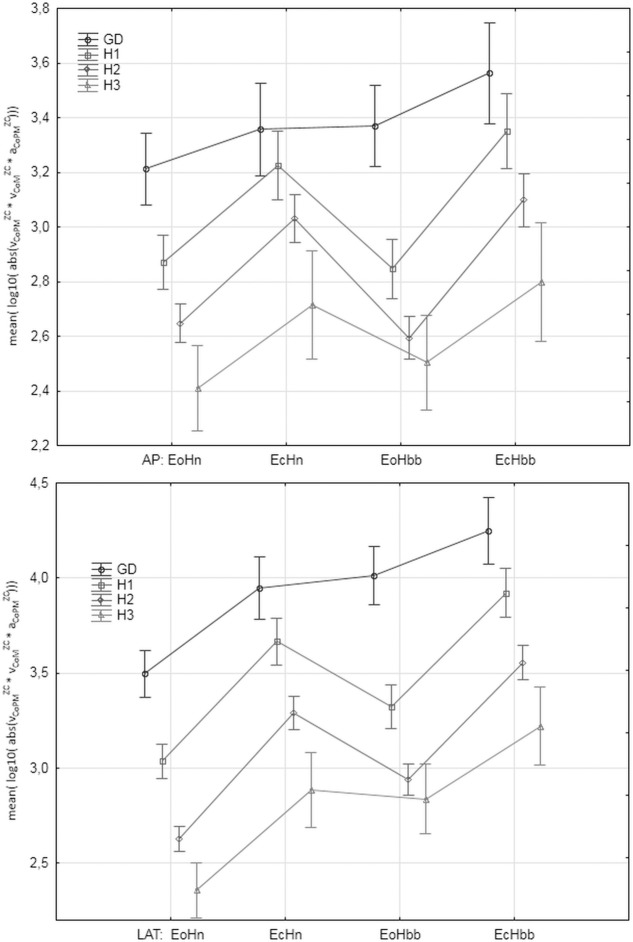
The mean values of ML = mean(log10 (|vCoPMZC· vCoMZC· aCoPMZC| )) in the subsequent patients and registration condition groups.ML represents the simple function of all the analyzed Zero-Crossing derived parameters. Upper: antero-posterior (AP), bottom: lateral (LAT) component of the signal. Markers denote the standard error of the mean.